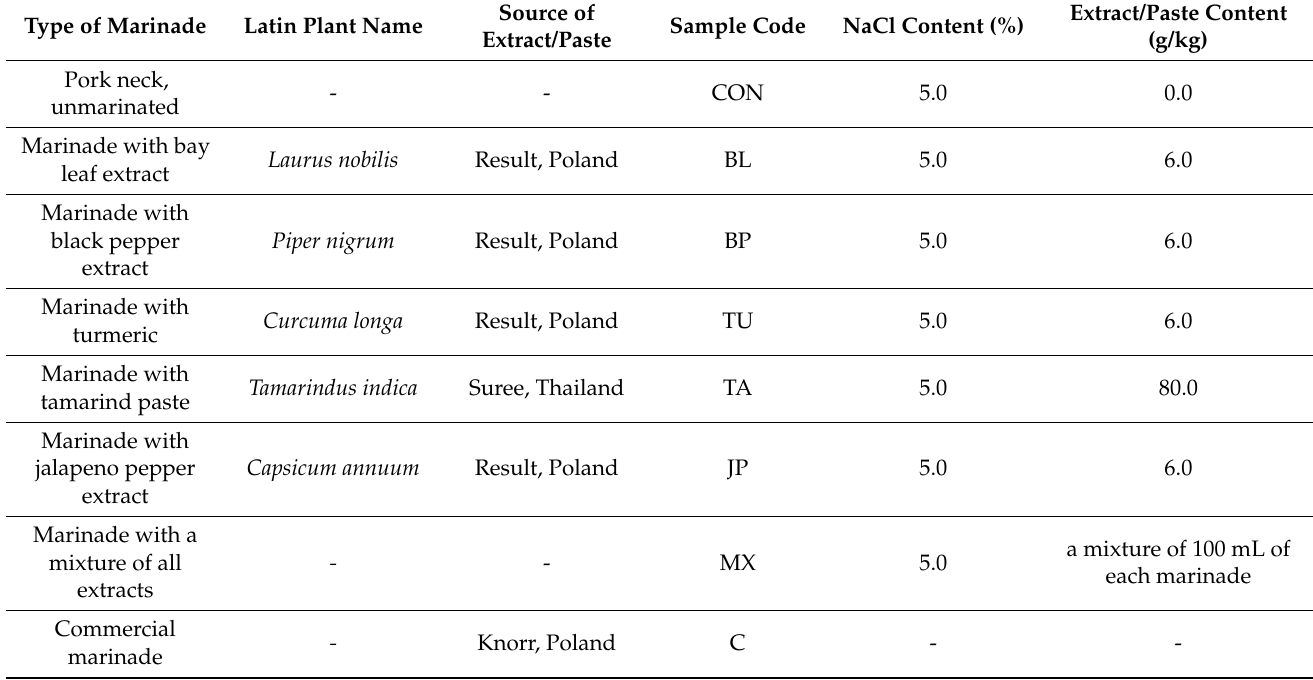
Table 1. Type and amount of marinade extracts, NaCl content and names of study groups.